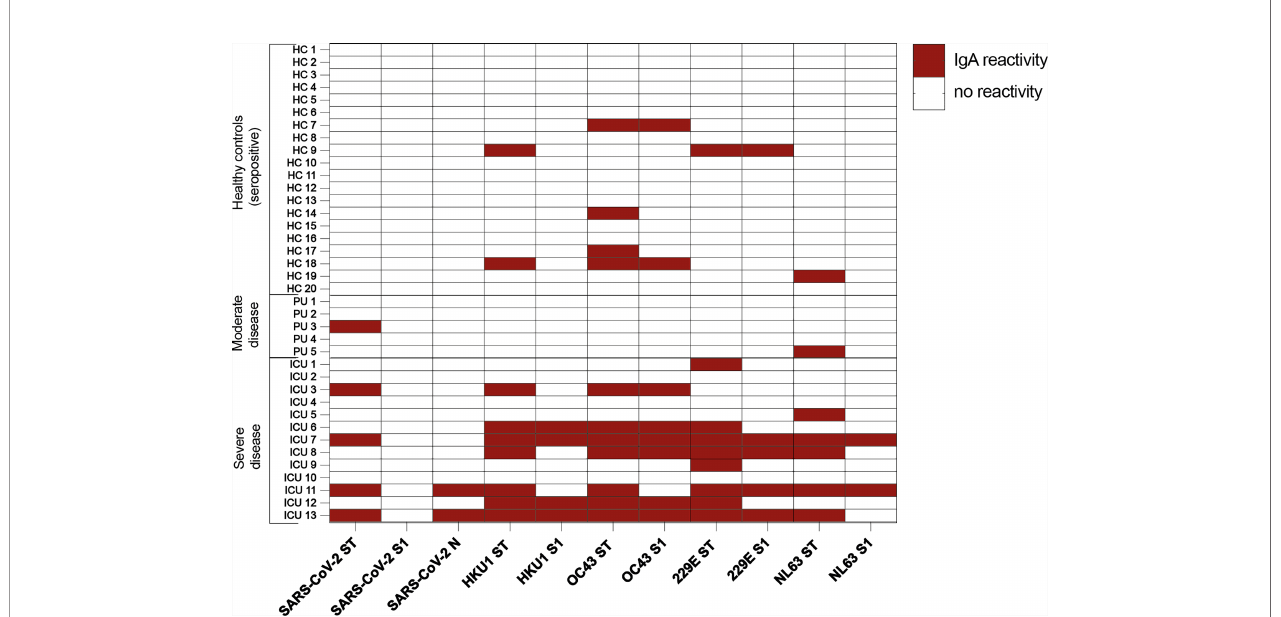
FIGURE 4 | Positive IgA responses detected in saliva of patients with severe COVID-19. Heatmap visualization of IgA antibody titers against recombinant trimeric spike proteins and monomeric S1 subunits of SARS-CoV-2 and eCoVs measured by protein microarray in serially diluted saliva samples of COVID-19 patients with moderate and severe disease compared to seropositive healthy controls. Positive responses are indicated by red squares. ICU, intensive care unit; PU, pulmonary